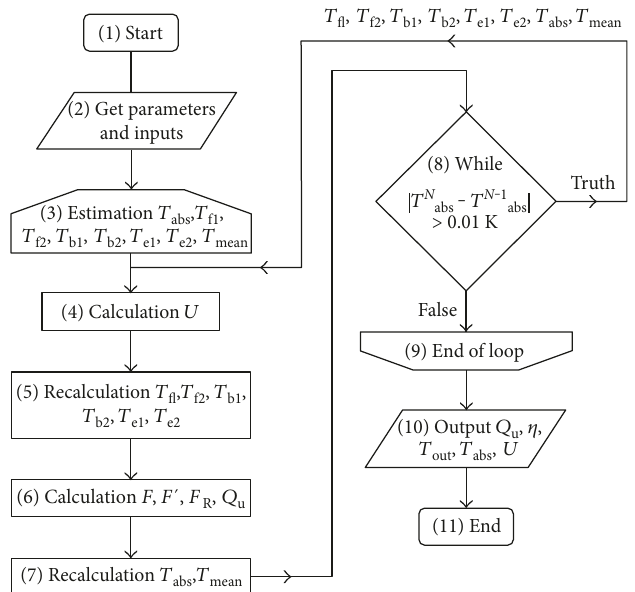
Figure 5: Flow chart of the iteration loop.